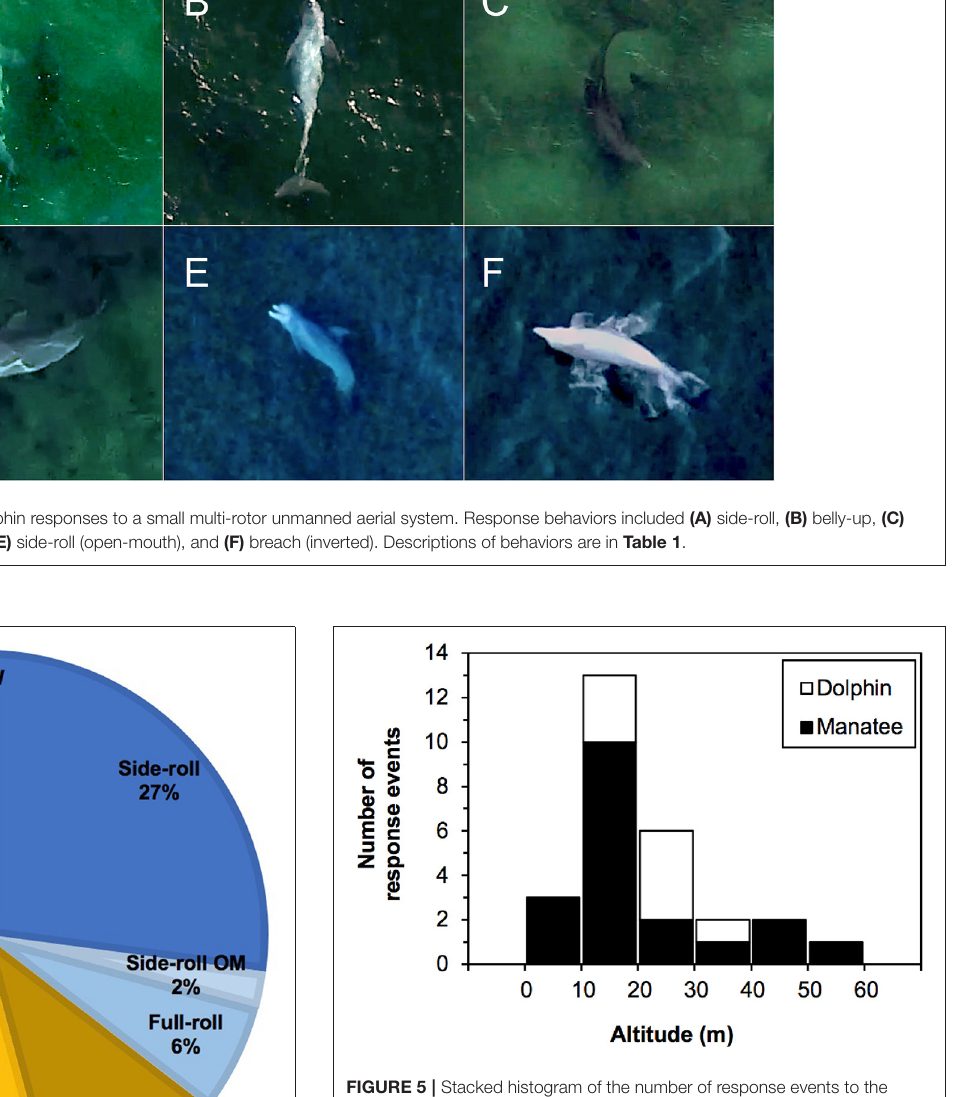
FIGURE 5 | Stacked histogram of the number of response events to the aircraft in bottlenose dolphins and Antillean